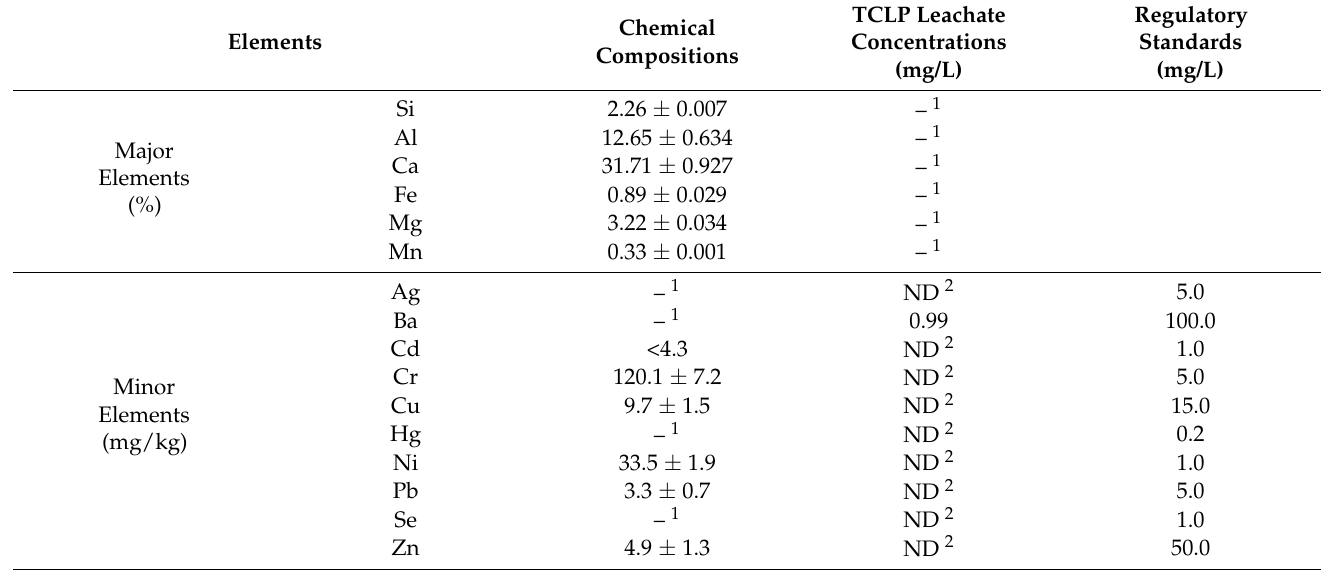
Table 1. Elemental and leaching characteristics of ladle slags.